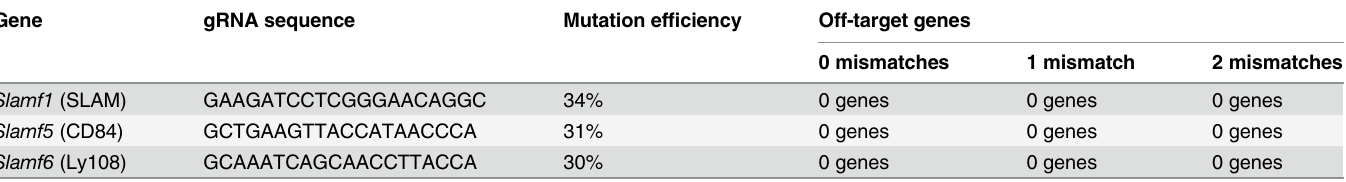
Table 1. gRNA sequences and characteristics.